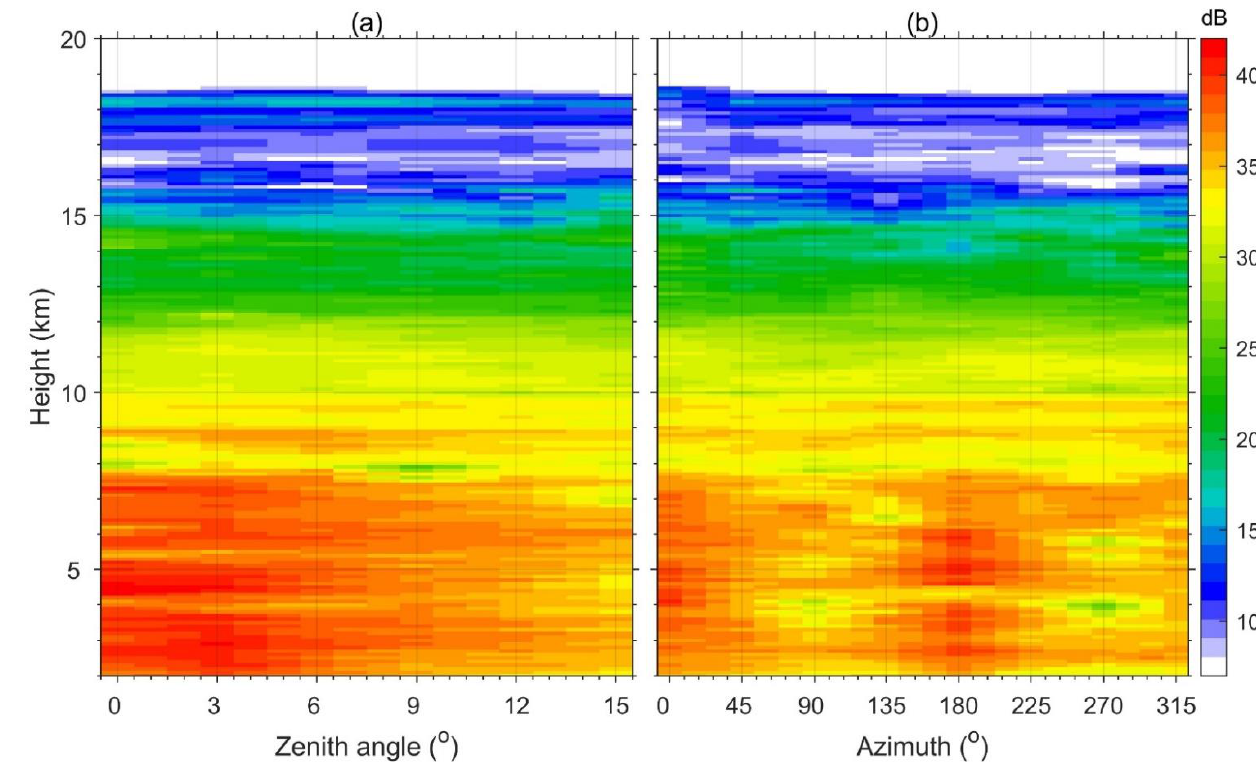
Figure 4. Daily mean height distribution of the signal-to-noise ratio (SNR, dB) versus zenith angle (( a ) azimuth = 45°) and azimuth (( b ) zenith angle = 12°) on 21 July 2021, in experiment #3.